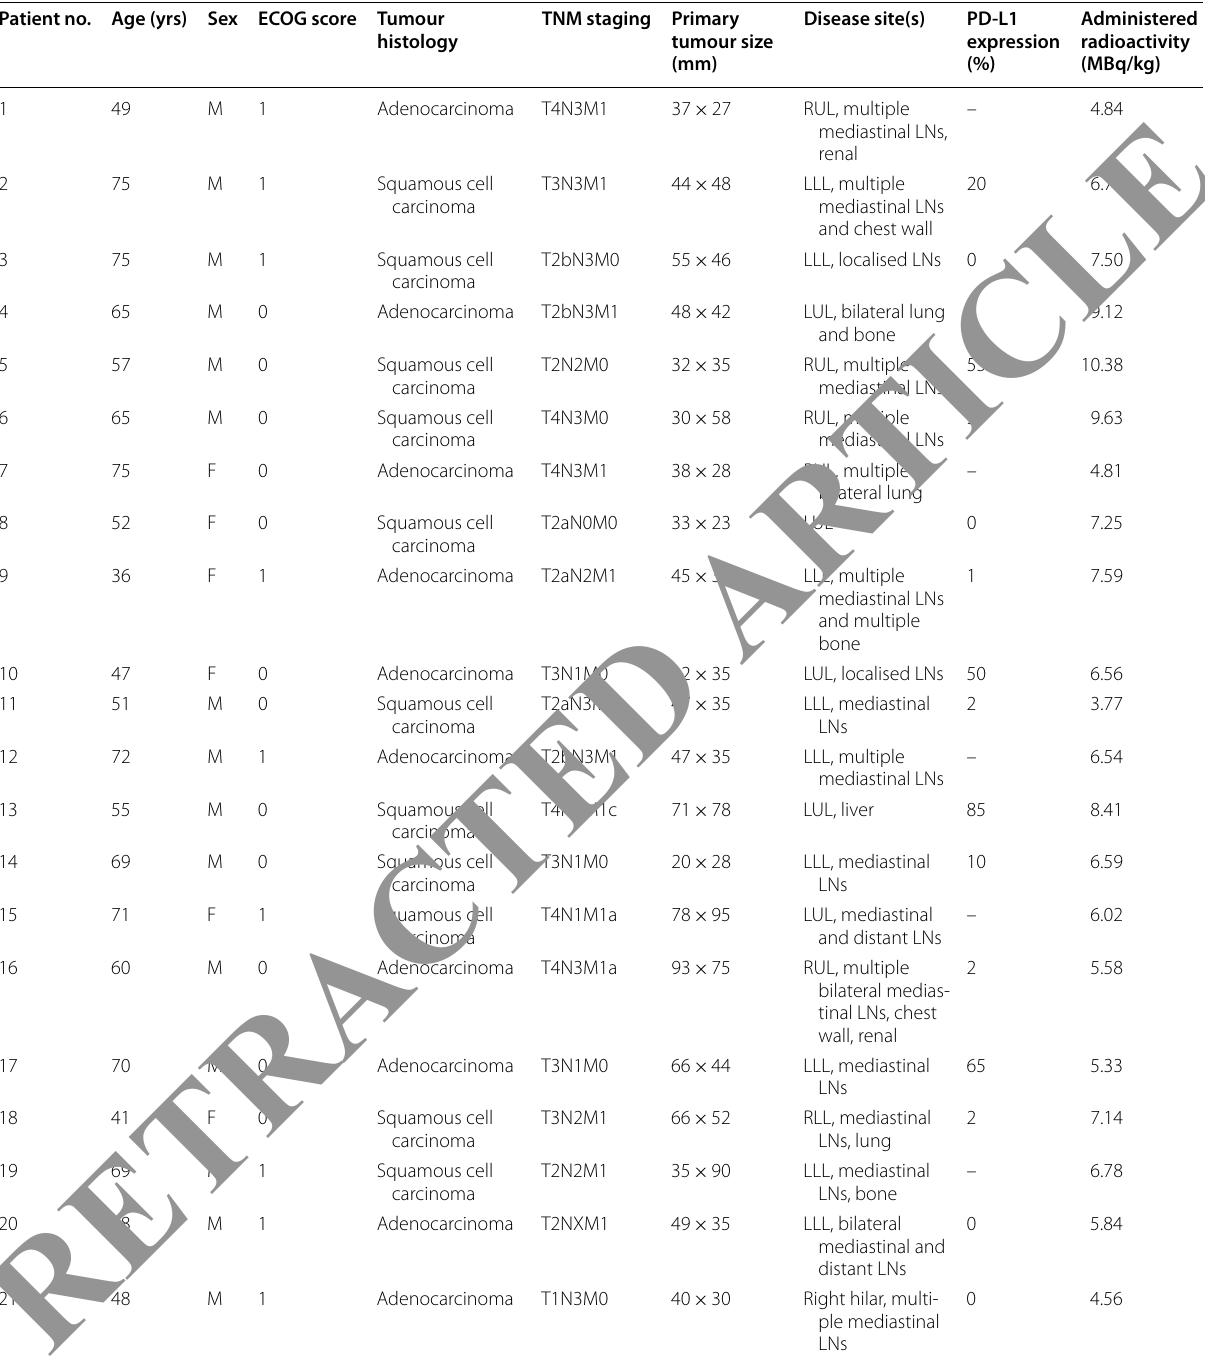
ECOG Eastern Cooperative Oncology Group Performance score, – denotes an inconclusive result, LLL left lower lobe, LNs lymph nodes, LUL left upper lobe, RLL right lower lobe, RUL right upper lobe